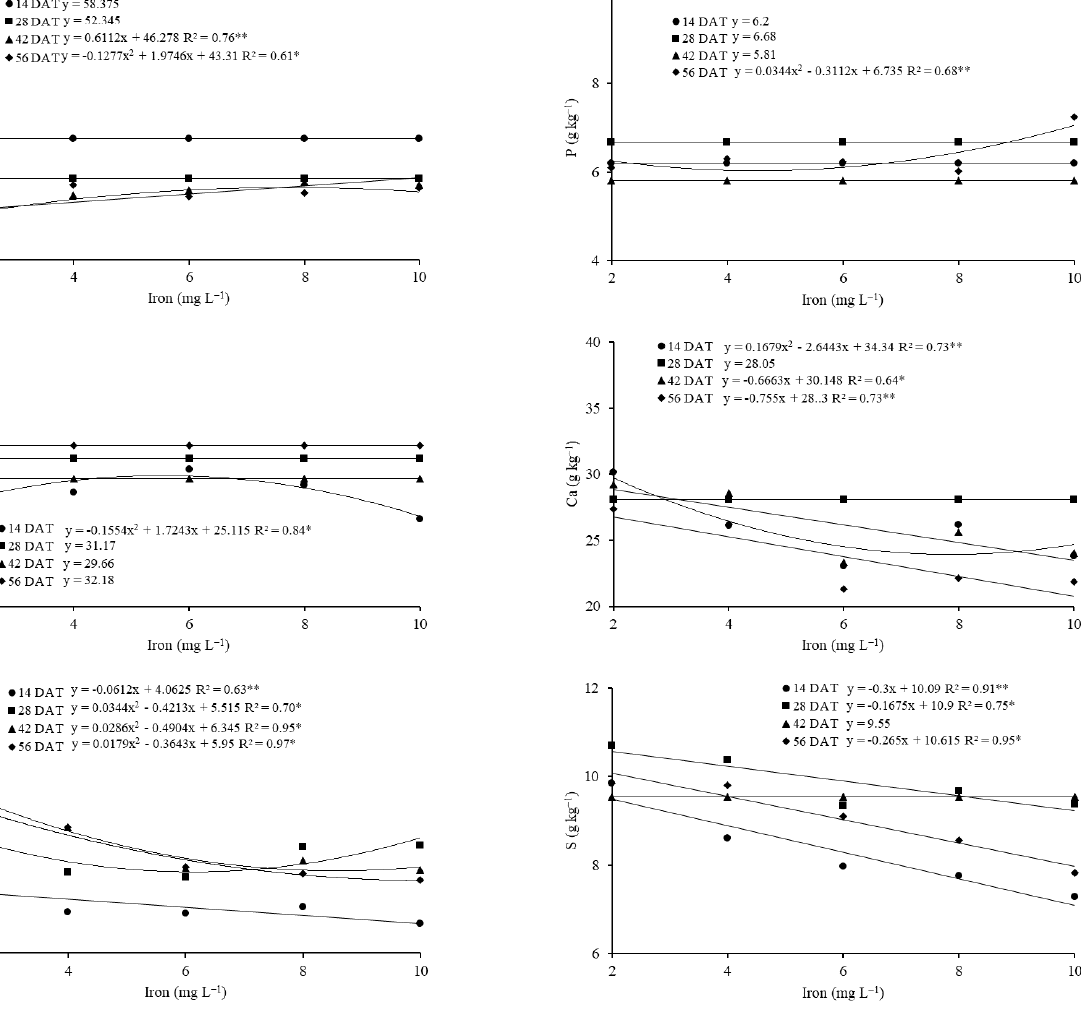
Figure 2. Foliar contents of nitrogen (N), phosphorus (P), potassium (K), calcium (Ca), magnesium (Mg) and sulfur (S) in collard greens as a function of iron concentration in the nutrient solution at 14, 28, 42 and 56 days after the application of treatments (DAT). Significant at * p ≤ 0.05 and ** p ≤ 0.01.